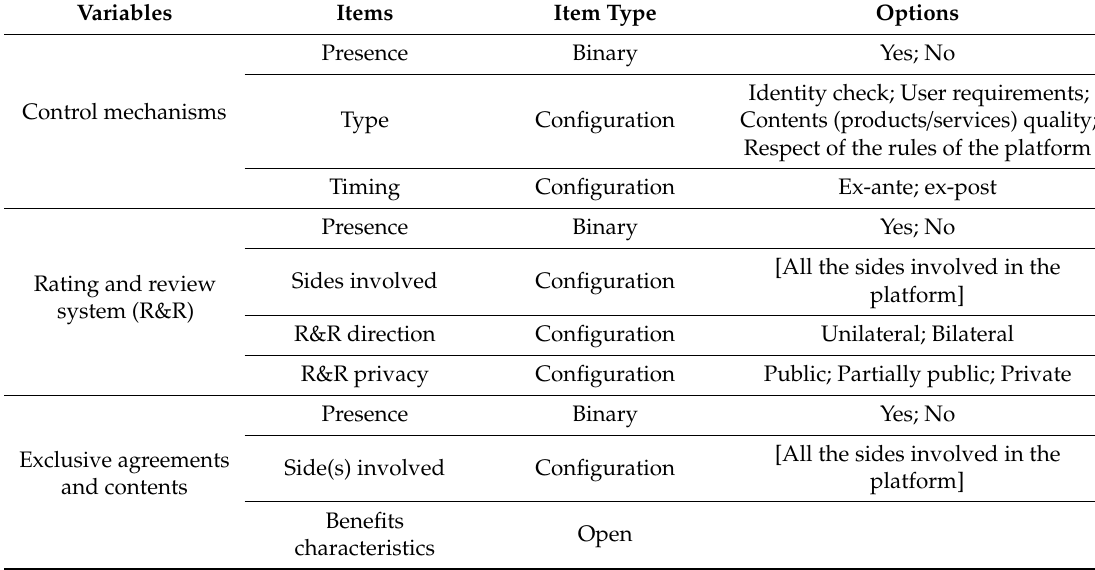
Table 8. Variables, items and configuration options for the “platform control” dimension.